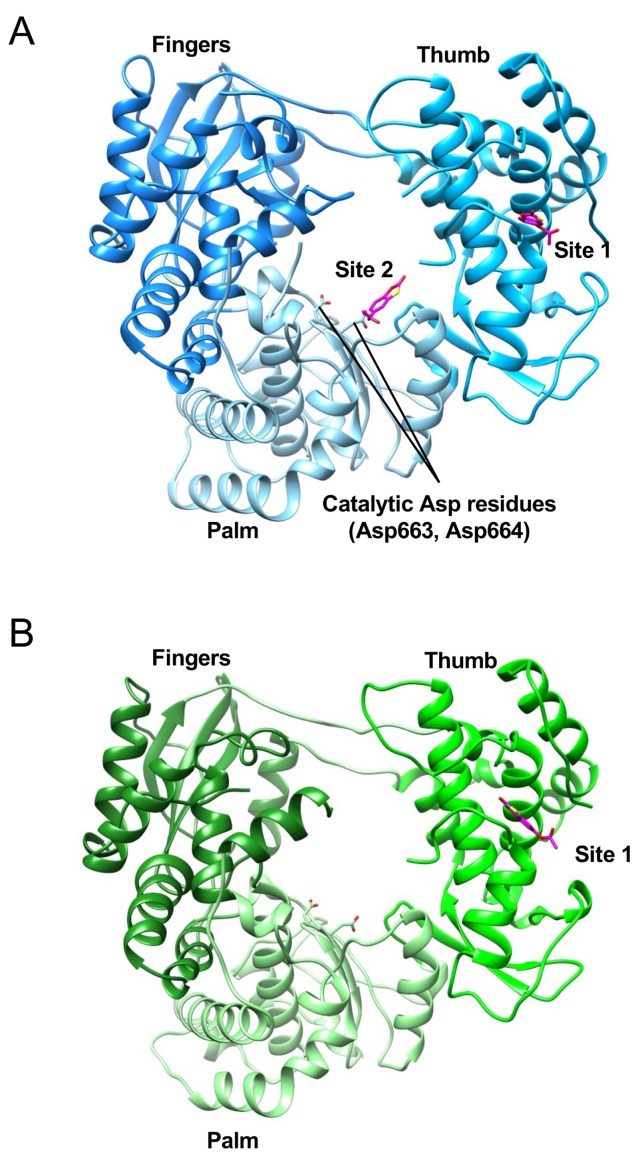
Crystal structures of the DENV2 and DENV3 RdRp domains in complex with RK-0404678.A-B. Overall structures of the DENV2 (A) and DENV3 (B) RdRps, shown in ribbon representations. The bound RK-0404678 molecules are depicted by magenta stick models.